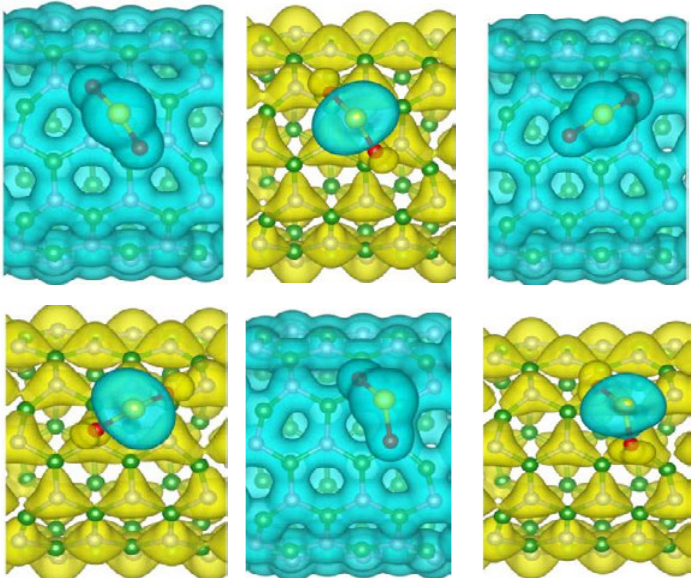
Fig. 5. Isosurface plots of HOMOs and LUMOs for SO Figure 5. Isosurface plots of HOMOs and LUMOs for SO 2 adsorbed BN nanotubes.